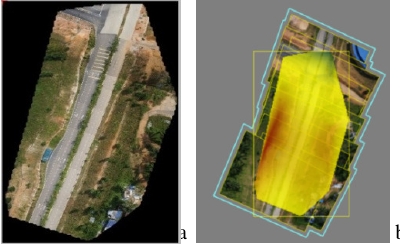
Figure 5. Results (80m); (a) Orthophoto, (b)